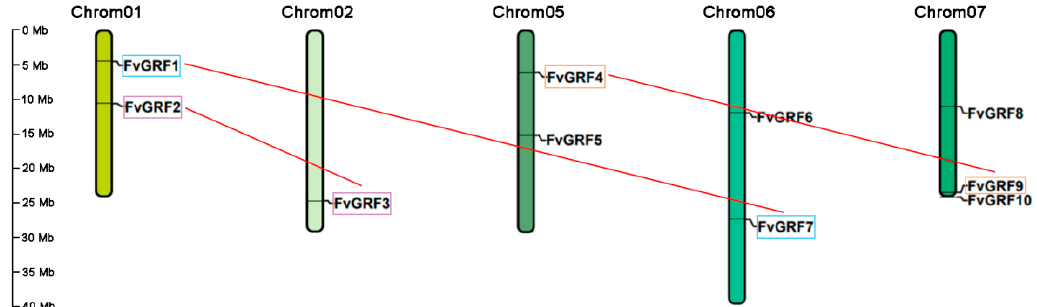
Figure 2. Chromosomal location of FvGRF genes of woodland strawberry. The chromosomal location of each FvGRF gene was determined in accordance with the woodland strawberry genome assembly v4.0.a1. The number of each chromosome is shown above the chromosome. Replicated fragments are represented by a colored box connected by a red line. Note: FvGRF1 (FvH4_1g08440.1), FvGRF2 (FvH4_1g18220.1), FvGRF3 (FvH4_2g32670.1), FvGRF4 (FvH4_5g10750.1), FvGRF5 (FvH4_5g23900.1), FvGRF6 (FvH4_6g18130.1), FvGRF7 (FvH4_6g34730.1), FvGRF8 (FvH4_7g12130.1), FvGRF9 (FvH4_7g32780.1), and FvGRF10 (FvH4_7g34250.1).